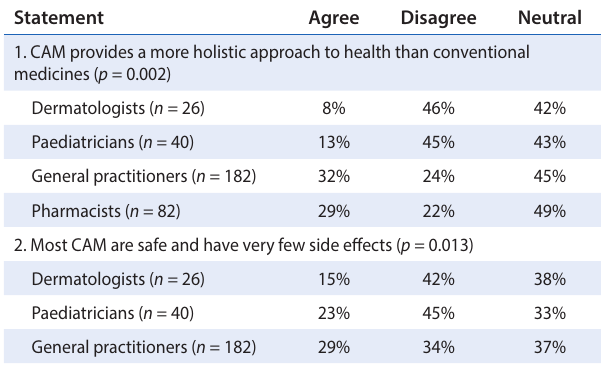
Table 1: South African healthcare professionals’ views/attitudes towards